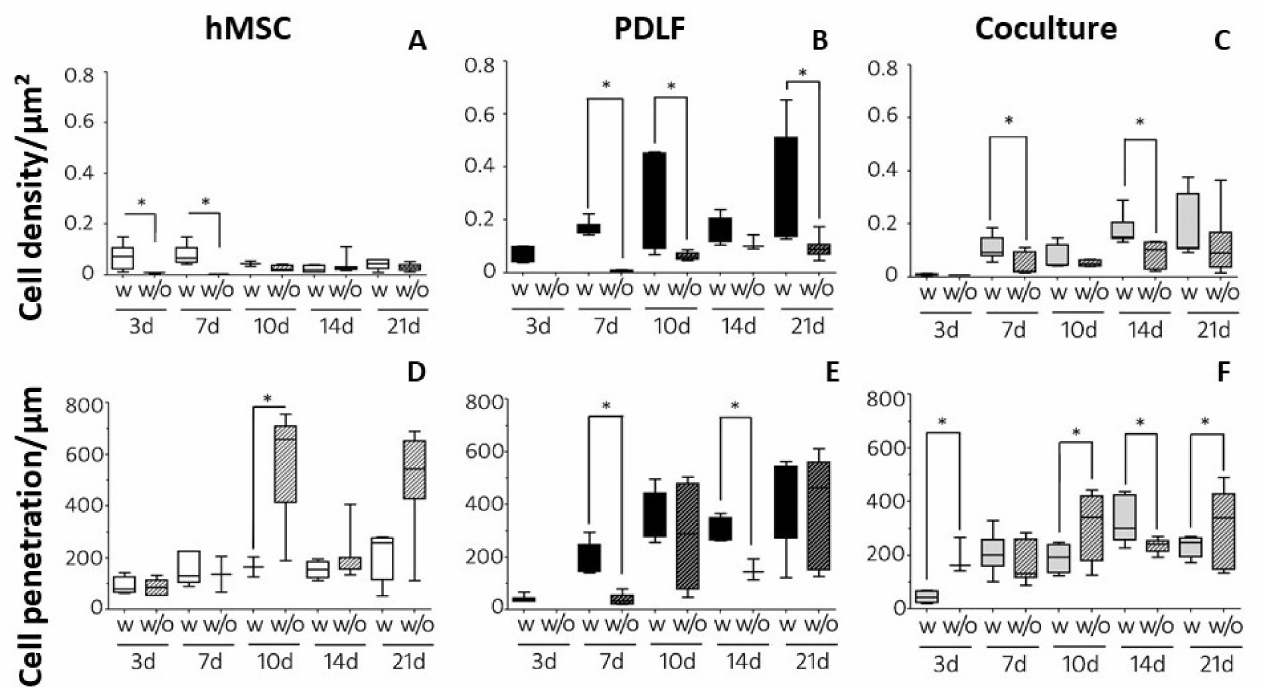
Figure 4. Statistical evaluation of the 4 (cid:48) ,6-diamidin-2-phenylindol e (DAPI) stained sections after incubation for 3, 7, 10, 14, and 21 d. ( A – C ) Quantitative analysis of cell densities (cells/ µ m 2 ) on nonwovens with (=eGHA ap = w) or without (=eGHA = w/o) additional porosity populated by ( A ) hMSCs, ( B ) PDLFs, and ( C ) cocultures of both cell types. The boxplots represent the median values and interquartile ranges. The whiskers depict the 1.5-fold interquartile ranges. PDLFs on d 3 on eGHA could not be evaluated for technical reasons. ( D , E ) Quantitative analysis of the maximum cell penetration ( µ m) on nonwovens with (=eGHA ap = w) or without (=eGHA = w/o) additional porosity populated by ( D ) hMSCs, ( E ) PDLFs, or ( F ) cocultures of both cell types. The boxplots represent the median values and interquartile ranges. The whiskers depict the 1.5-fold interquartile ranges. Numerical data for the graphs can be found in the Supplementary Tables S1 and S2. *: p <